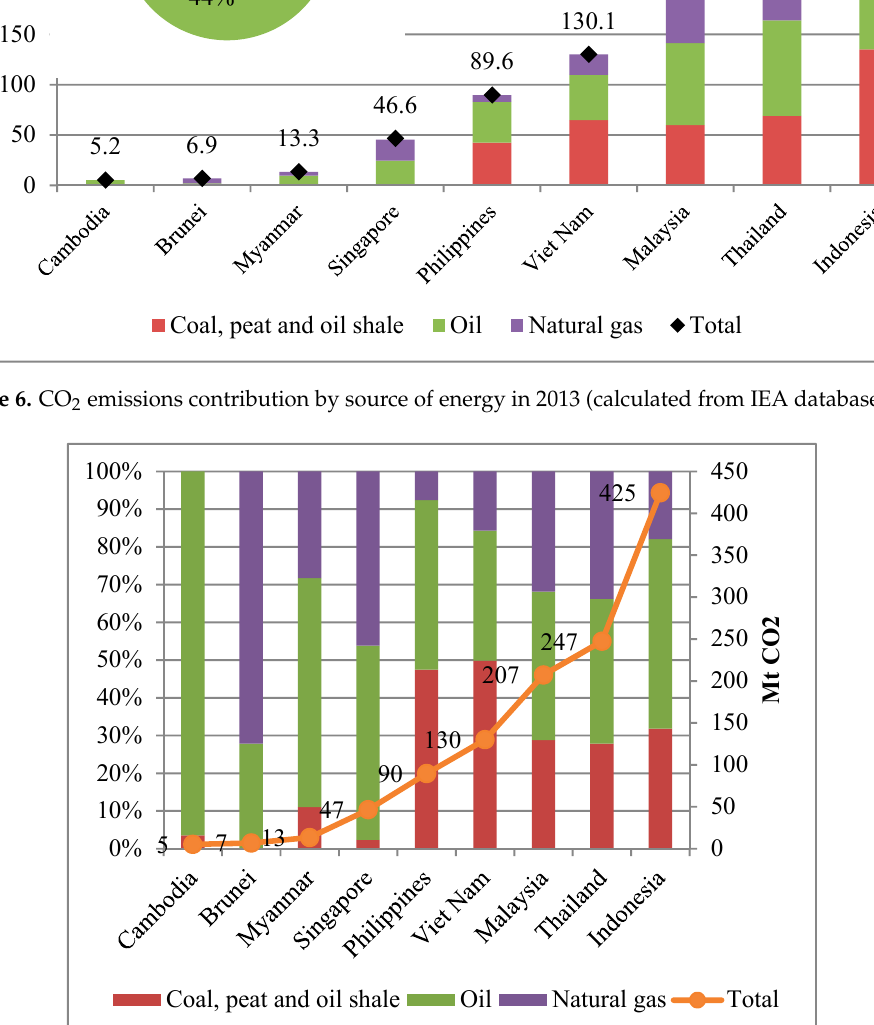
Figure 7. Share of CO 2 emissions by sources of energy in 2013 (calculated from IEA database 2015).